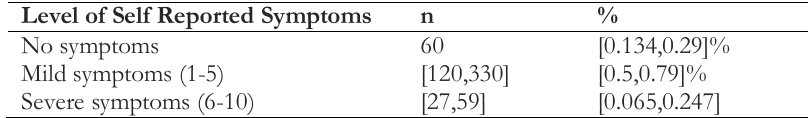
Table 5. Distribution of level of self reported symptoms on RTI/STIs among women